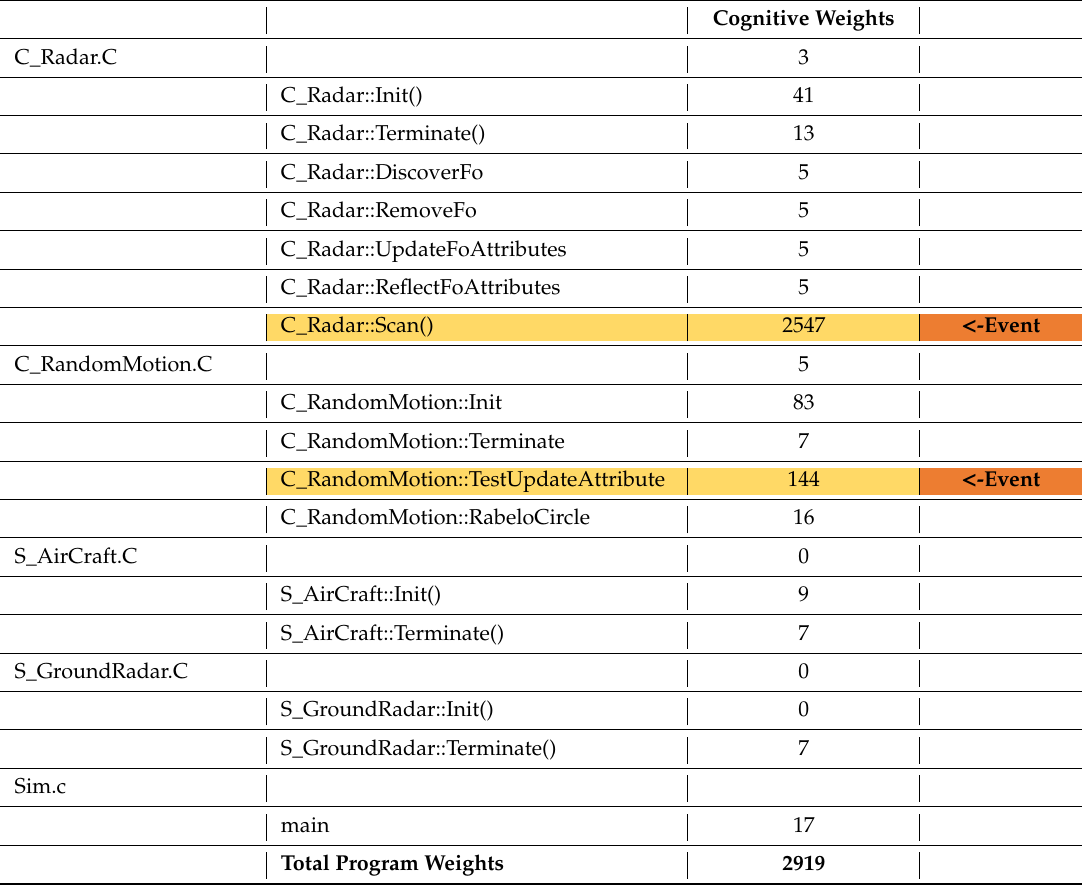
Table 4. Calculation of cognitive weights for the case study.